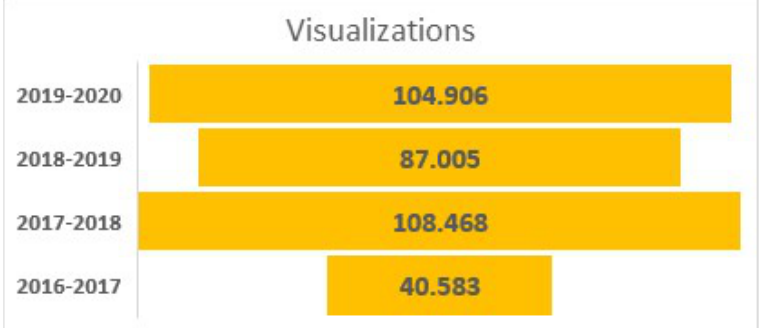
Figure 10. Visualizations of We Propose! Project, Source: Geography blog by Juan Martín Martin.